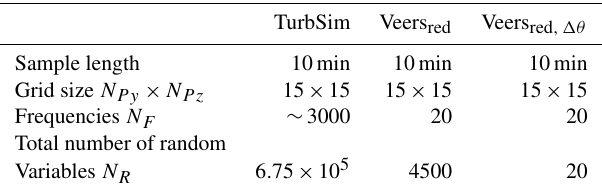
Table 1. Comparison of random numbers used in different wind models for a common grid size. TurbSim Veers red Veers red ,(cid:49)θ